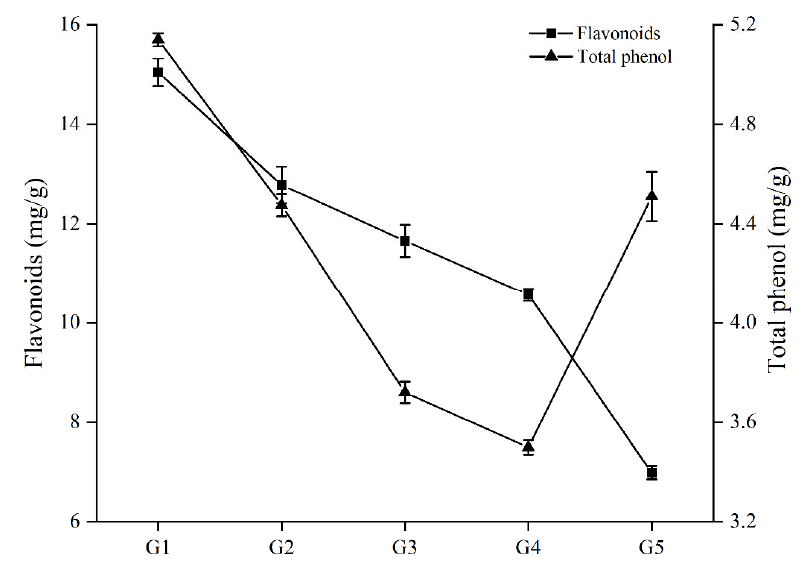
Figure 1. Contents of flavonoids and total phenols in pickled BLS with different salt concentrations. G1, G2, G3, G4, and G5 represent the BLS samples pickled with 4%, 5%, 6%, 7%, and 8% salt mass.